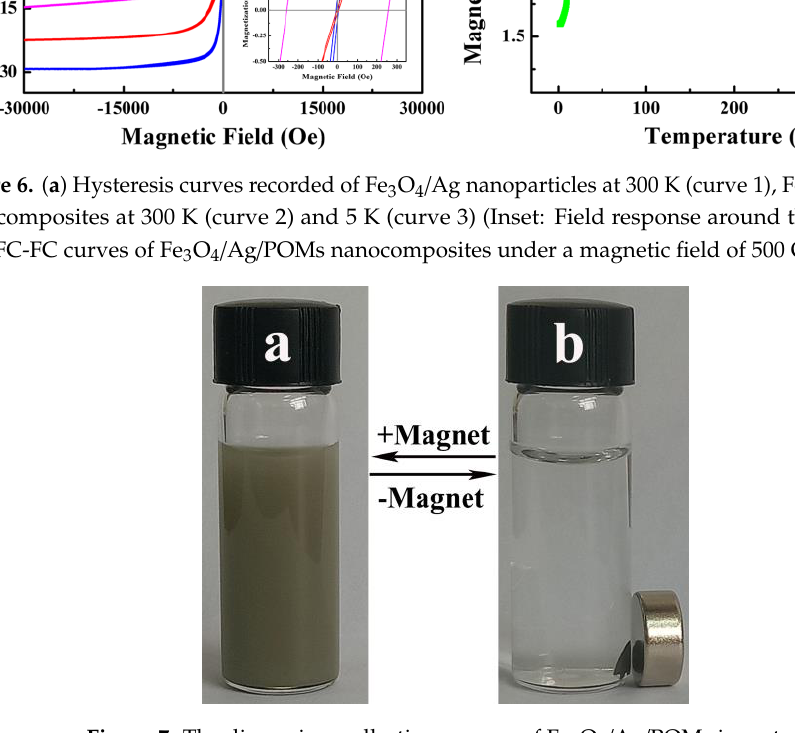
Figure 7. The dispersion–collection process of Fe 3 O 4 /Ag/POMs in water.